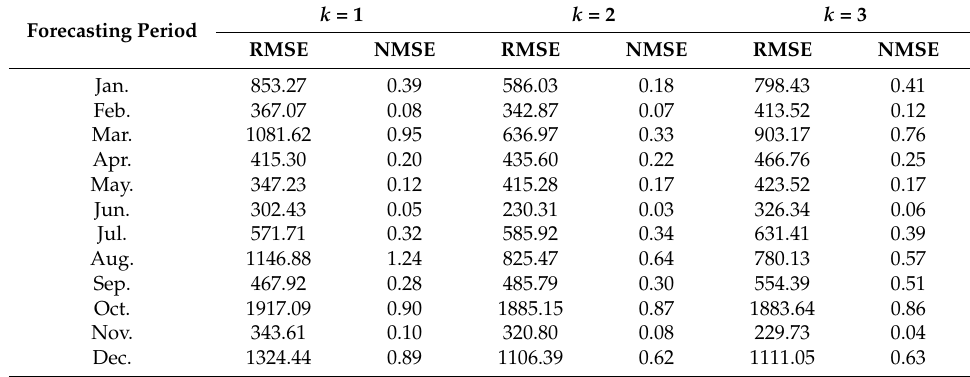
Table 1. Comparison of the errors of different nearest neighbor numbers (the value of k ) in small samples (unit: MW).